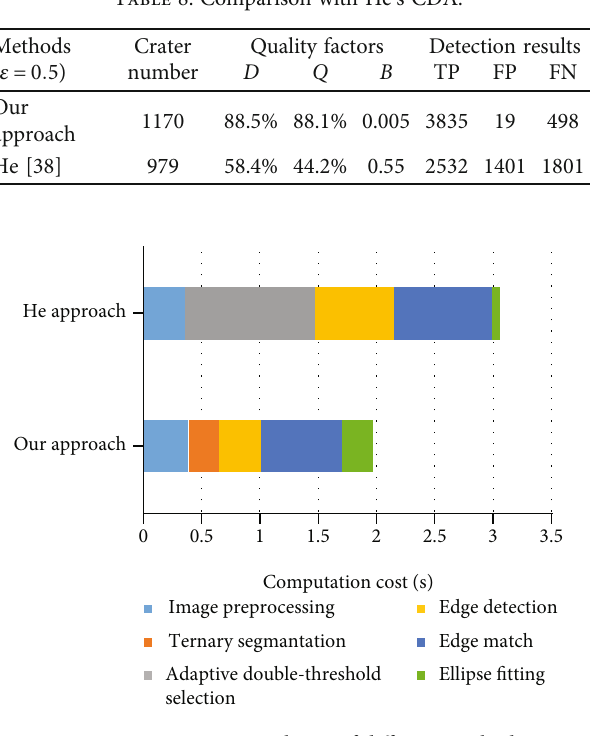
Figure 14: Computational cost of di ff erent